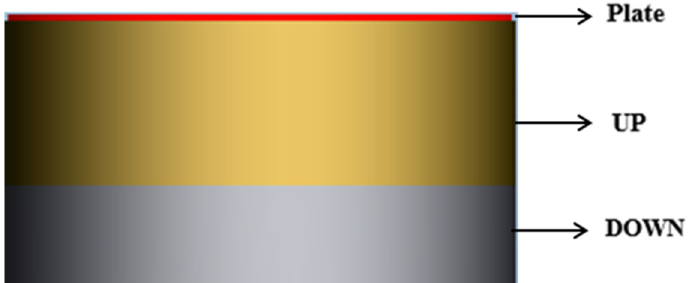
Figure 10. Diagram of direct shear box parts.